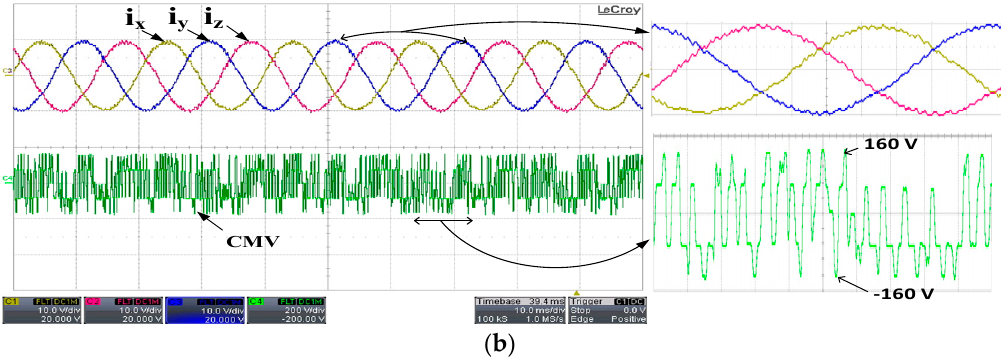
Figure 5. Each phase current and common mode voltage (CMV) for Case 1 ( a ) Simulation result, ( b ) Experimental result ( I = 10 A/div. CMV = 200 V/div. and 10 ms/div.).